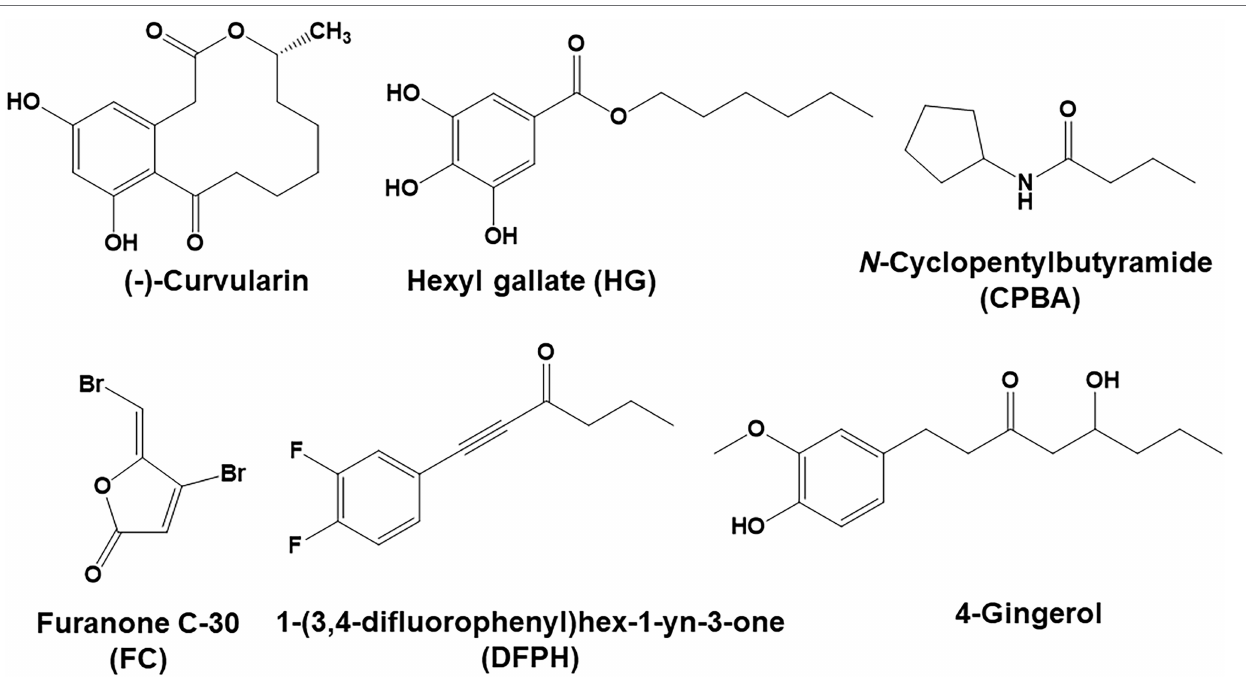
FIGURE 1 | ( − )-Curvularin and related